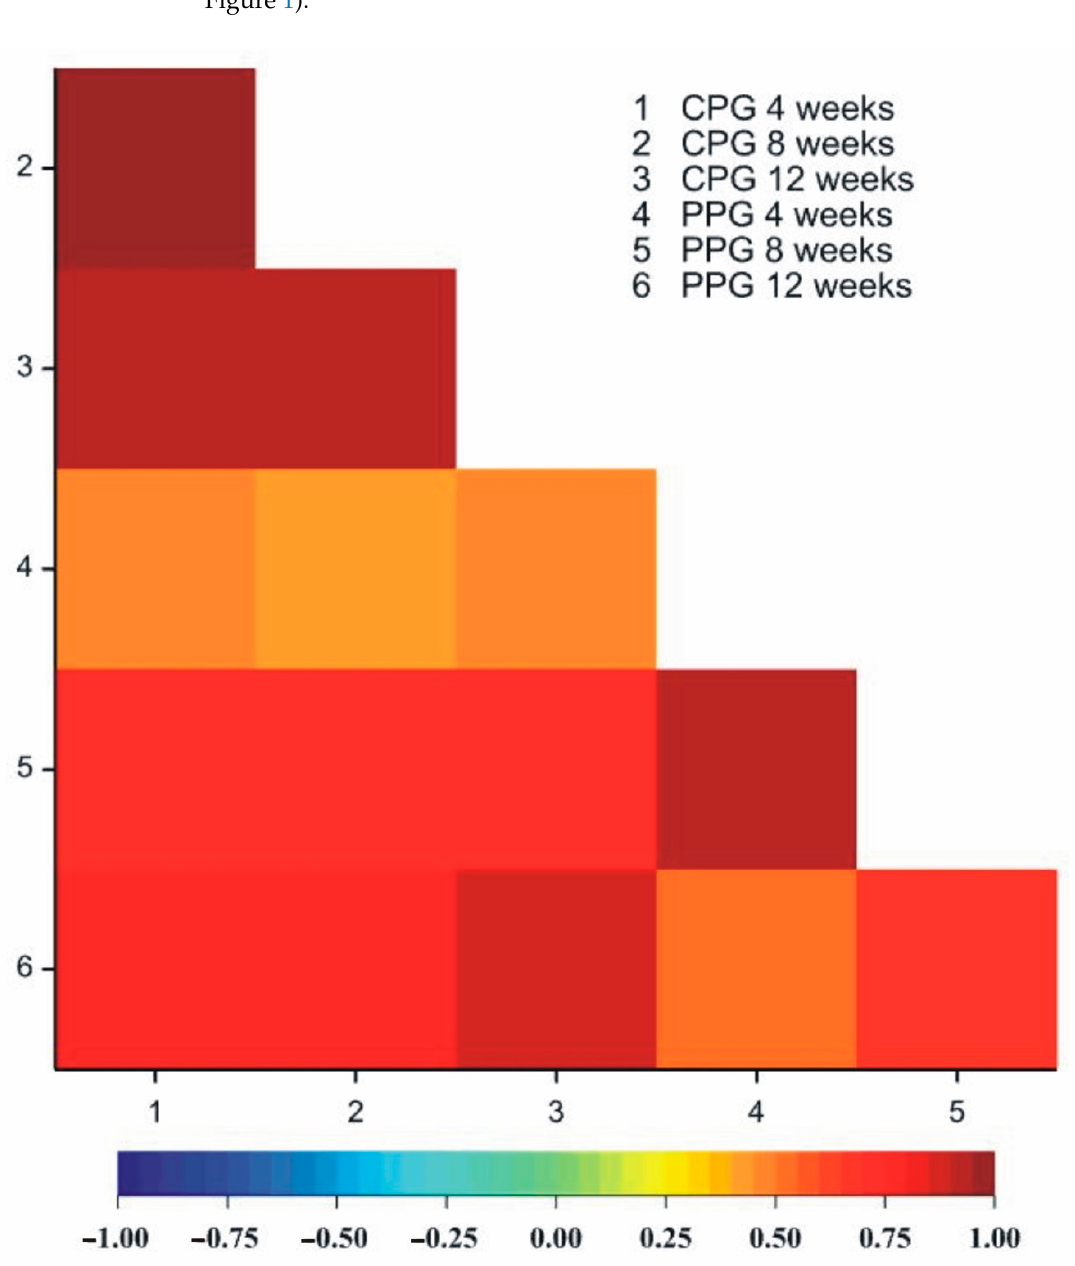
Figure 1. Heatmaps for linear Pearson’s correlation coefficients between the observed traits: CPG and PPG in 4, 8 and 12